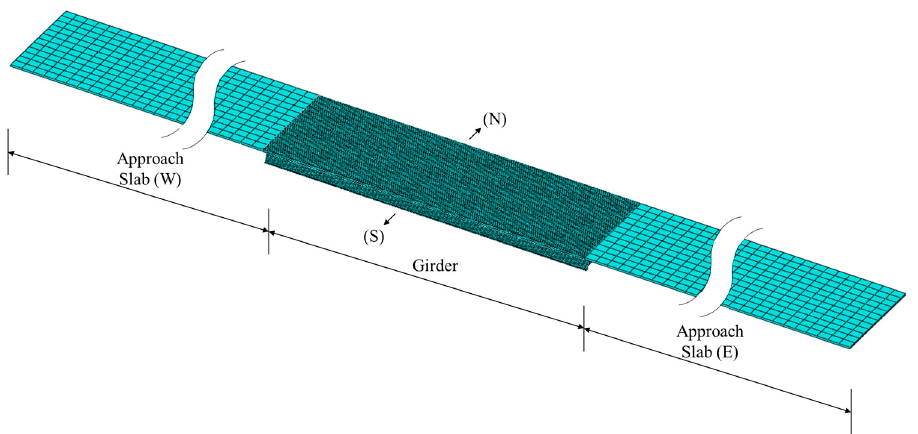
Figure 2. Three-dimensional finite element models of the bridge.